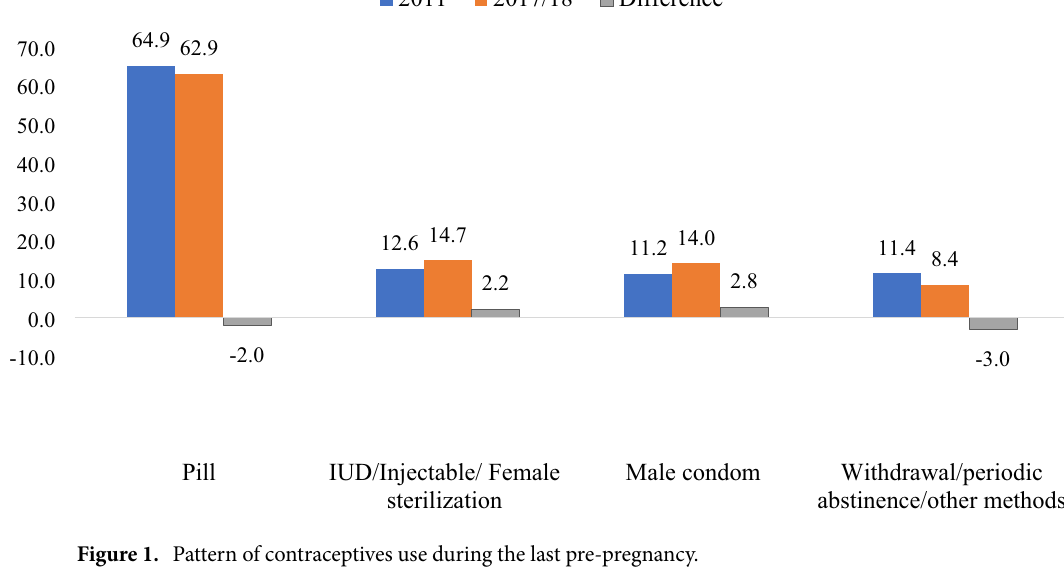
Figure 1. Pattern of contraceptives use during the last pre-pregnancy.